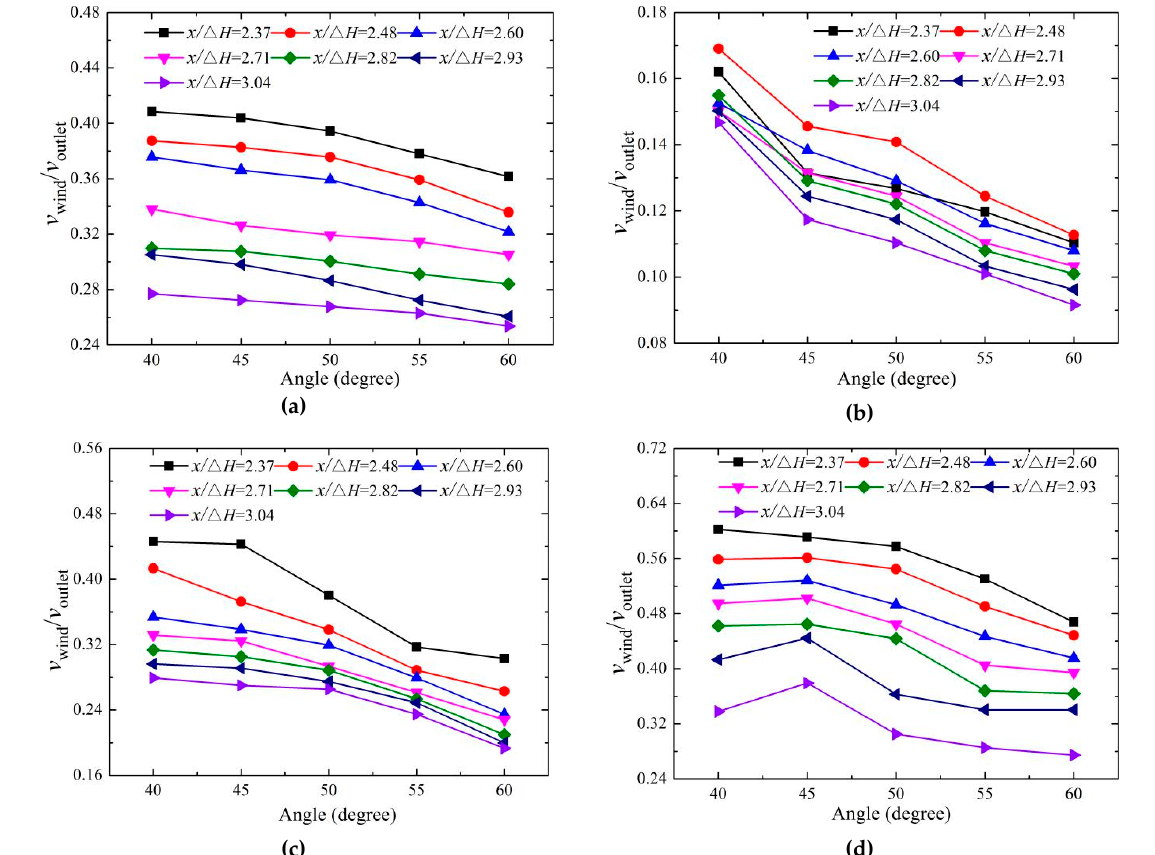
Figure 10. The two-dimensional distribution of the nappe wind for di ff erent bucket angles at z / ∆ H = 0: ( a ) CB ( y / ∆ H = 0), ( b ) CB ( y / ∆ H = 0.448), ( c ) TB ( y / ∆ H = 0), and ( d ) TB ( y / ∆ H = 0.448).